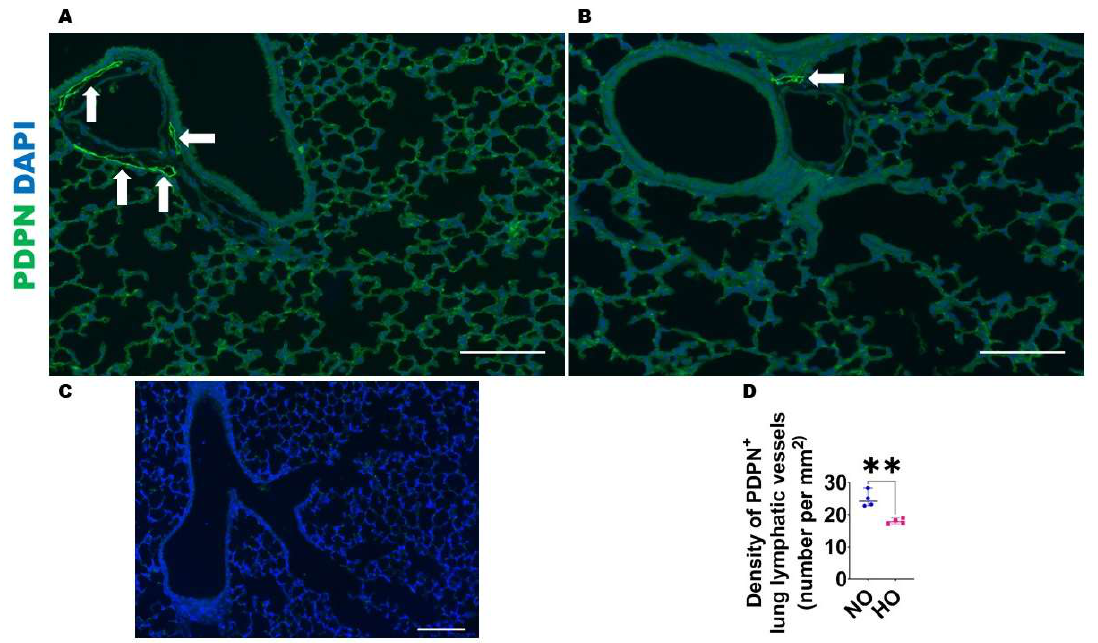
Figure 5. Lung VEGFR3 + lymphatic density in neonatal mice exposed to HO. The lung lymphatic density was determined by quantifying VEGFR3 + lung vessels (arrows) on P14 in WT mice exposed to 21% O 2 (NO) or 70% O 2 (HO) from P1 to P14. A-B. Representative VEGFR3 + (red), αSMA (green), and DAPI (blue) immunofluorescence-stained lung sections from mice exposed to NO ( A ) and HO ( B ) for 14 d. ( C ). Representative lung section from NO exposed animals stained with secondary antibodies only (negative control). Scale bar = 100 µm. ( D ). Quantification of VEGFR3 + lung vessels. Values are presented as the median with the range ( n = 4/group). Significant differences between exposures are indicated by **, p < 0.01 ( t -test).